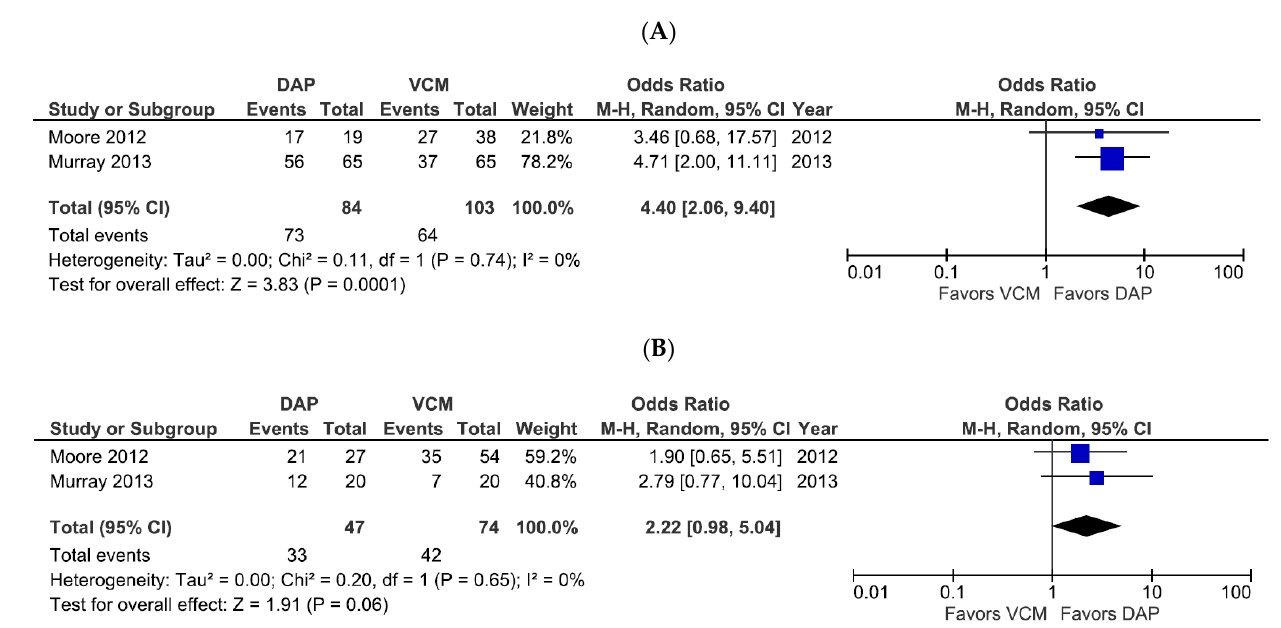
( A ) ( B ) Figure 2. Forest plots of all-cause mortality and treatment success rates for patients treated with DAP versus VCM for bacteremia caused by MRSA with VCM MIC > 1 µg/mL. ( A , B ) Forest plots of the all-cause mortality rate ( A ) and treatment success rate ( B ) of patients treated with DAP versus